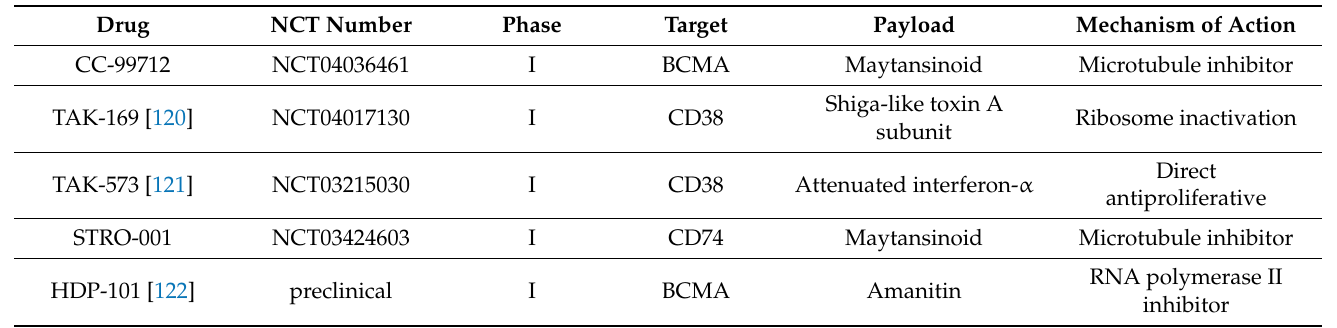
Table 10. Ongoing/planned trials for other